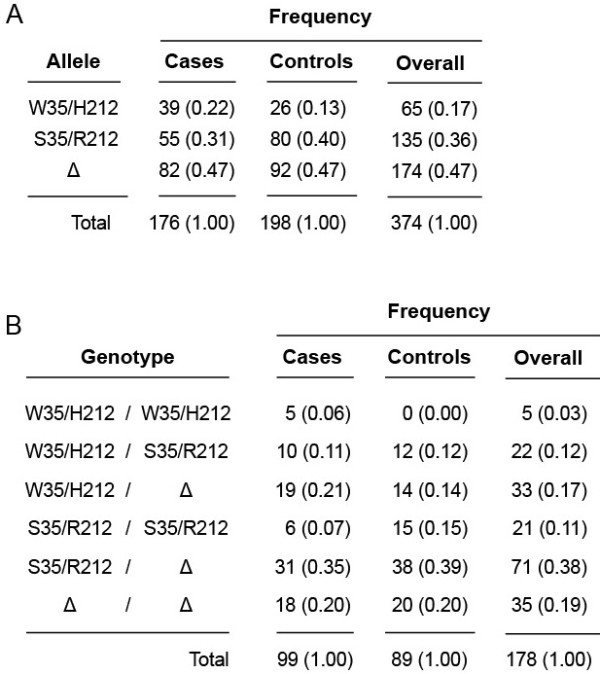
Genetic data. AOccurrence of TAS2R43-W35/H212, -S35/R212 and Δ alleles in subjects. Counts are given, with frequencies shown in parentheses. B Genotype frequencies in subjects.